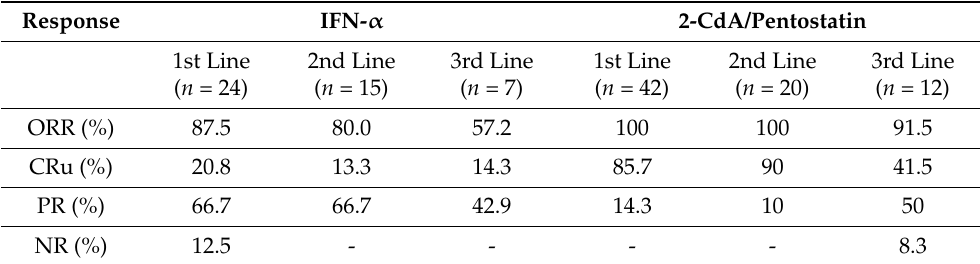
Table 3. Response after first and subsequent lines of treatment with IFN- α or purine analogues.